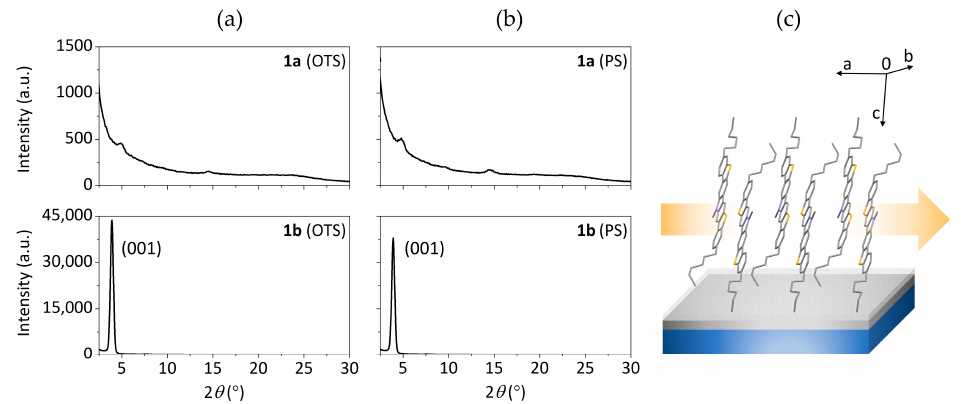
Figure 7. GIXRD patterns of vacuum-deposited films of compounds 1a – b on: ( a ) OTS- and ( b ) PS- treated Si/SiO 2 substrates; ( c ) proposed molecular disposition of 1b in the film based on the reflections observed in the GIXRD patterns, with the (001) plane situated parallel to the substrate and the arrow indicating the resulting π - π stacking direction. Hydrogens have been excluded for